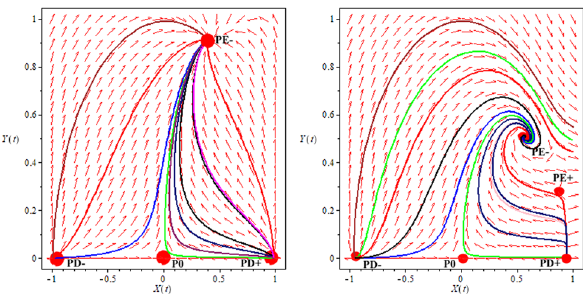
Fig. 3 Phaseportraitofthedynamicalsystem(21)and(22)forthecase α = 0 and the specific choice β = 0 . 01 ,λ = 1 (left panel) and β = 0 . 05 ,λ = 2 . 3(rightpanel). Inthefirstscenario,Point D + andPoint D − correspond to unstable nodes, Point O is saddle and Point E − describes an accelerated stable solution which can be of cosmological interest. For the latter scenario, Point D + and Point D − are related again with unstablenodes,Point O issaddle,Point E + (absentinthepreviouscase) is saddle and Point E − is a stable solution. This scenario is decelerated and it is not favored by observations. It is important to mention that the different colors of the trajectories are only for illustrative purposes